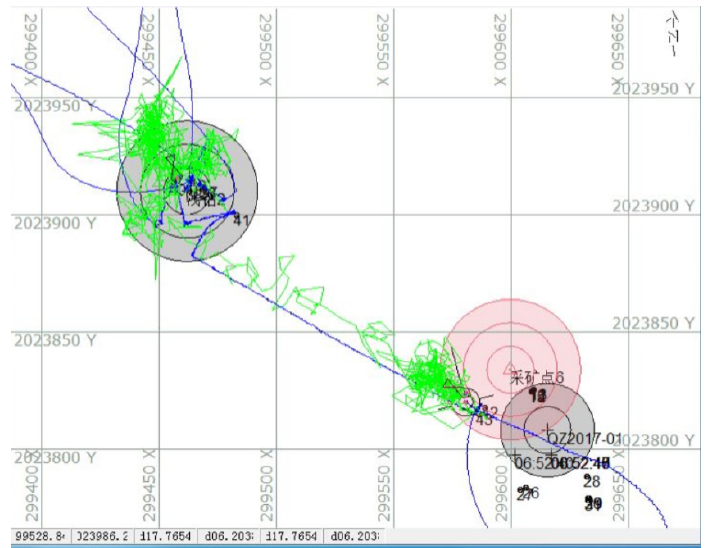
Figure 15. Trajectory diagram of the mining vehicle and support vessel (the green line is the vehicle’s trajectory, and the blue line is the support vessel’s trajectory).